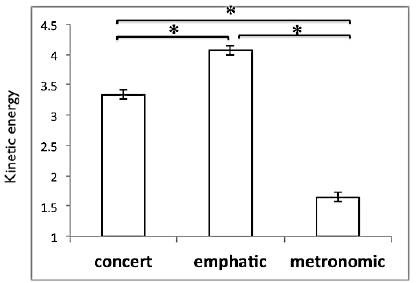
Figure 5. Main effect of the Expressivity condition on kinetic energy